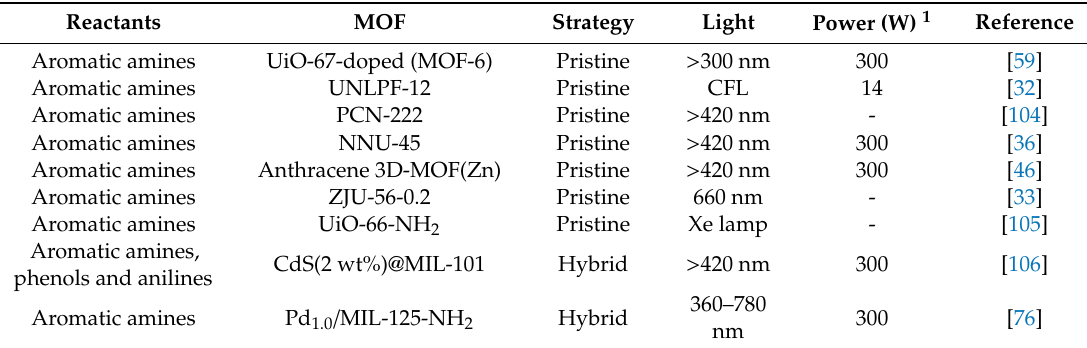
Table 10. Photooxidative couplings of primary amines mediated by MOFs.